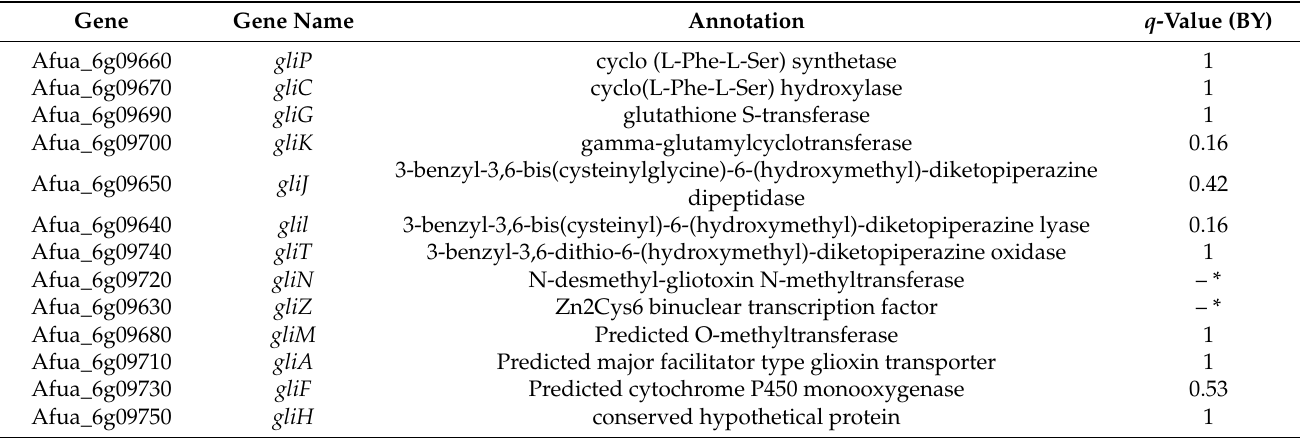
Table 2. Gliotoxin biosynthesis genes 1